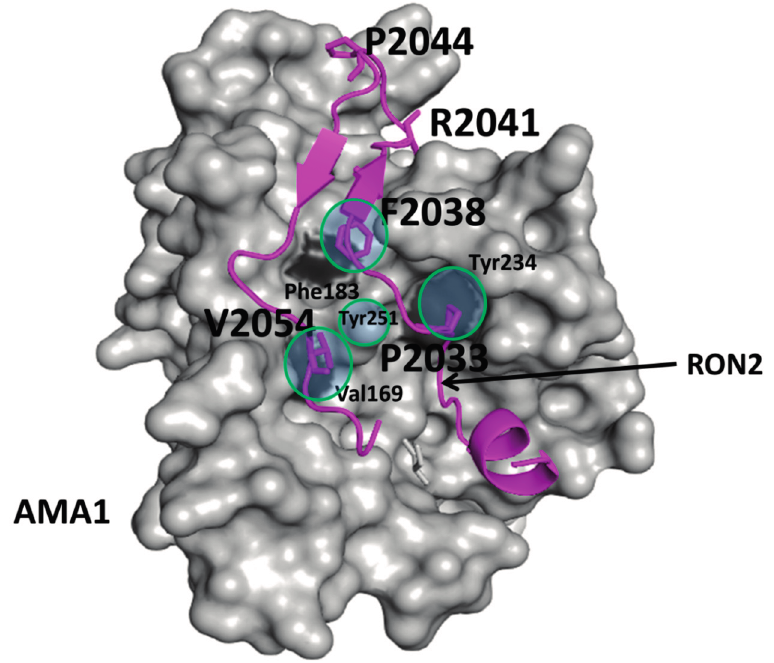
Figure 2. Crystal structure of complex of AMA1-RON2 peptide (PDB ID:3ZWZ).